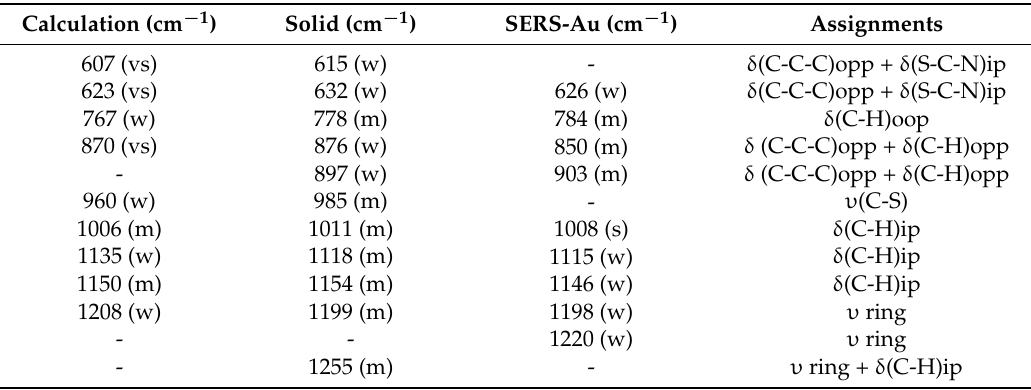
Table 1. The proposed assignment of Raman peaks of TBZ.